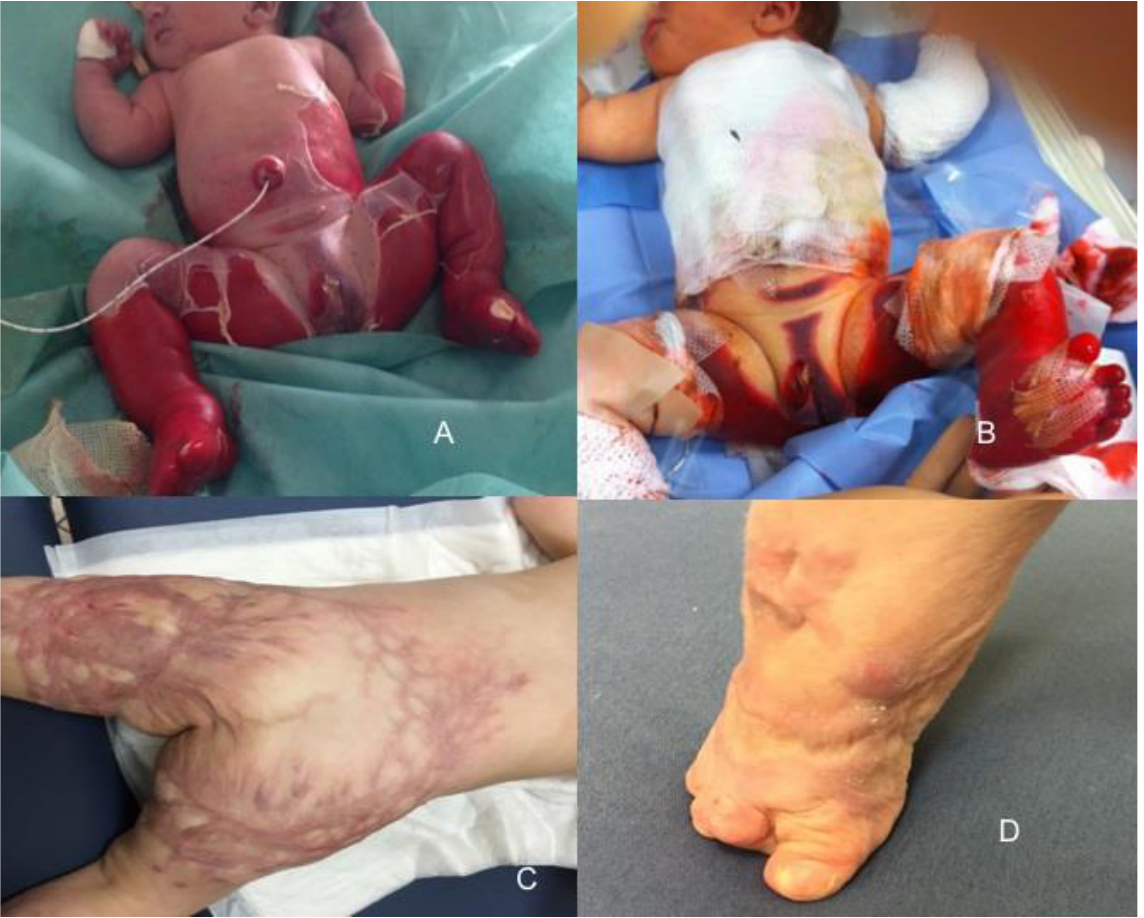
Figure 4. Case of burns in a neonate with overlapped Staphylococcal infection: the skin of more than half of the body was initially injured ( A ), with the second to fourth toes that appeared necrotic ( B ). Wounds healed after 38 days of therapy, with serious scars at six months of life requiring numerous plastic surgical interventions ( C and D ).